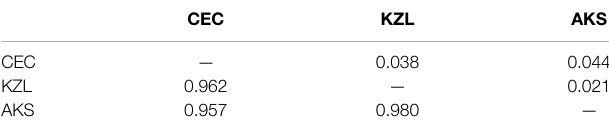
TABLE 6 | Nei ’ s genetic distance D (above diagonal) and genetic identity (blow diagonal) among the three populations of Schizothorax biddulphi .